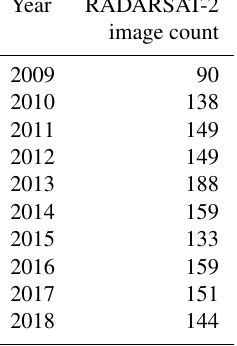
Table 1. Number of RADARSAT-2 images acquired over the Cana- dian Arctic Archipelago in April for